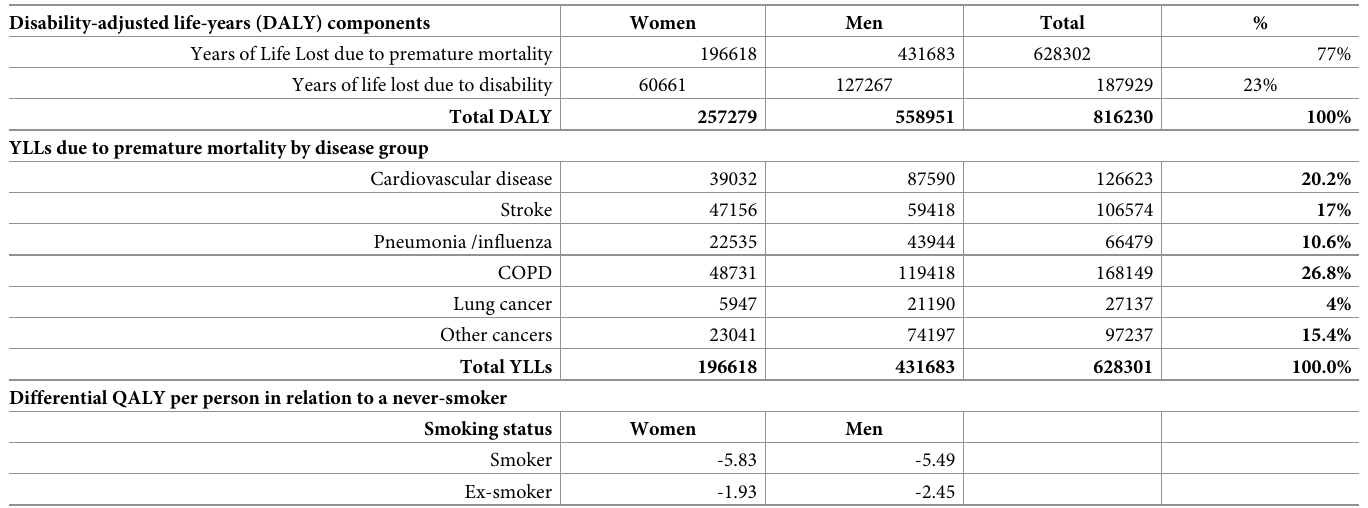
Table 4. Years of life lost (YLLs) due to premature mortality, disability, and total DALYs. Disability-adjusted life-years (DALY) components